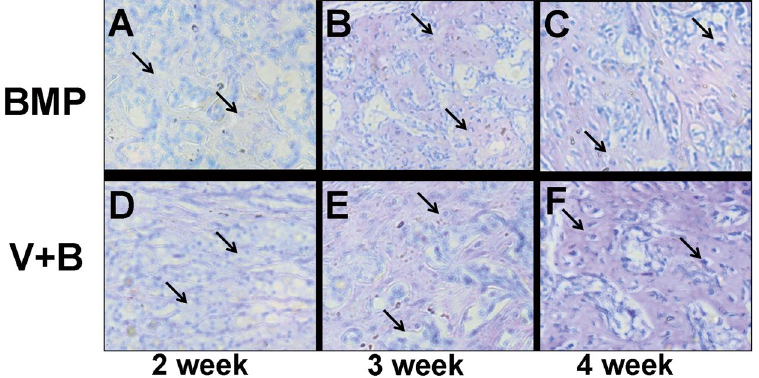
Figure 7. Toluidine blue staining of bone-like tissue B and BV group further proved the bone-like tissue formation.( A – C ) are analysis after injection of hydrogel for 2, 3 and 4 weeks for ( B ) group and ( D – F ) are that of 2, 3 and 4 weeks for BV group, respectively.